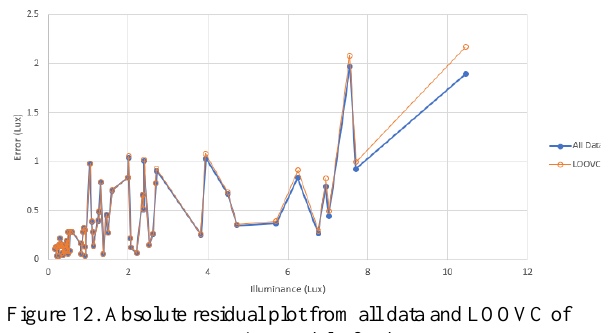
Figure 12. Absolute residual plot from all data and LOOVC of regression model of red.